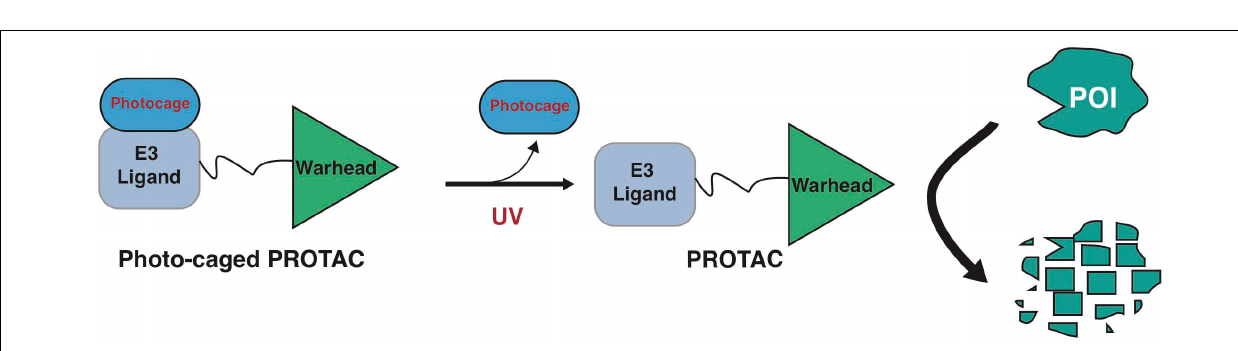
on PROTACs, making it more practicable and